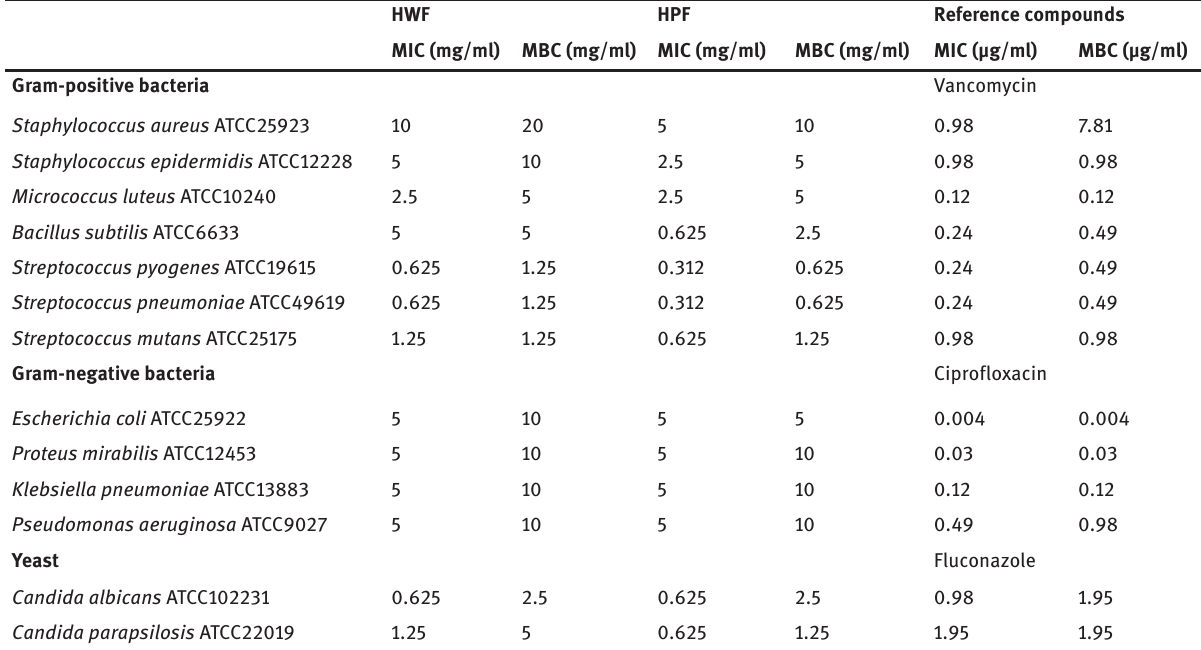
Table 2: Antimicrobial activity of essential oil obtained from white- (HWF) and pink- (HPW) flowered Hyssopus officinalis L. and reference compounds – vancomycin, ciprofloxacin for bacteria and fluconazole for